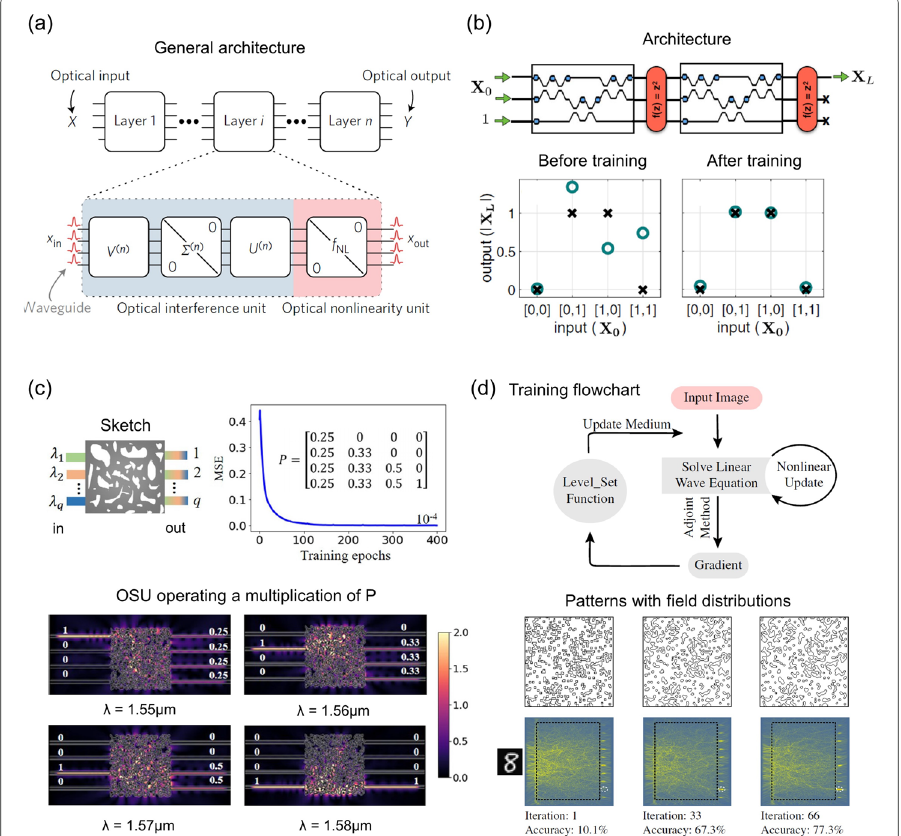
Fig. 10 (a) Optical interference unit (OIU) as a key component for optical neural network (ONN). A general ONN architecture was consisted of optical inputs (‘X’), internal multiple layers, and optical outputs (‘Y’). For a single internal layer (see a zoomed-in graph of ‘layer i’), it can be decomposed into OIUs (for matrix multiplications) joined with nonlinearity units (as the nonlinear activation). (b) An ONN-based XOR gate trained by the situ backpropagation and adjoint method. Top: the neural network containing inputs of X 0 , two layers of 3 × 3 OIUs (two rectangles), z 2 activations (two red blocks) and outputs of X L . Bottom: XOR gate properties before and after learning. The circles represent target function, and the crosses mean the true output of network. (c) A sketch of the optical scattering unit (OSU) to execute matrix multiplications. Right: training MSE errors (right corner: the targeted matrix P). Bottom: E-field distributions at wavelengths of 1.55, 1.56, 1.57, and 1.58 μ m, respectively. Each sub-image corresponds to one column of the matrix P. (d) An OIU-like nanophotonic medium to execute image detection. Top: the mini-batch stochastic gradient descent-based training process. All gradients information is calculated by adjoint state method in one step. Bottom: the media appearance and field distributions at iteration of 1, 33, and 66, respectively. The disordered media patterns (denoted by multiple inclusions embedded in a rectangle host material) progressively evolves upgrading the classification accuracy from 10.1% to 77.3%. Figures reproduced with permission: (a) Ref. [115], Copyright 2017 Nature Publishing Group; (b) Ref. [116], Copyright 2018 OSA; (c)